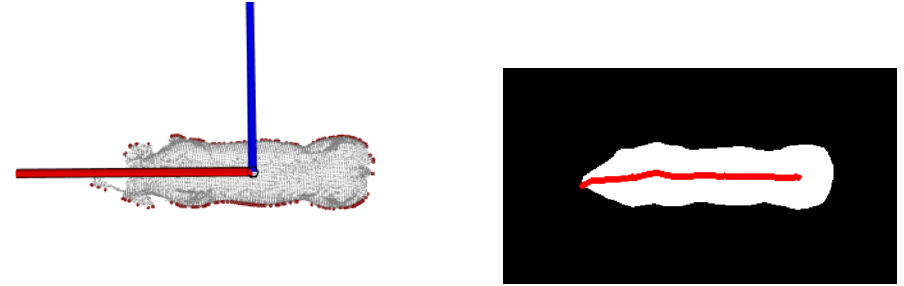
Figure 7. The constructed concave hull and the extracted torso skeleton for the top view of the